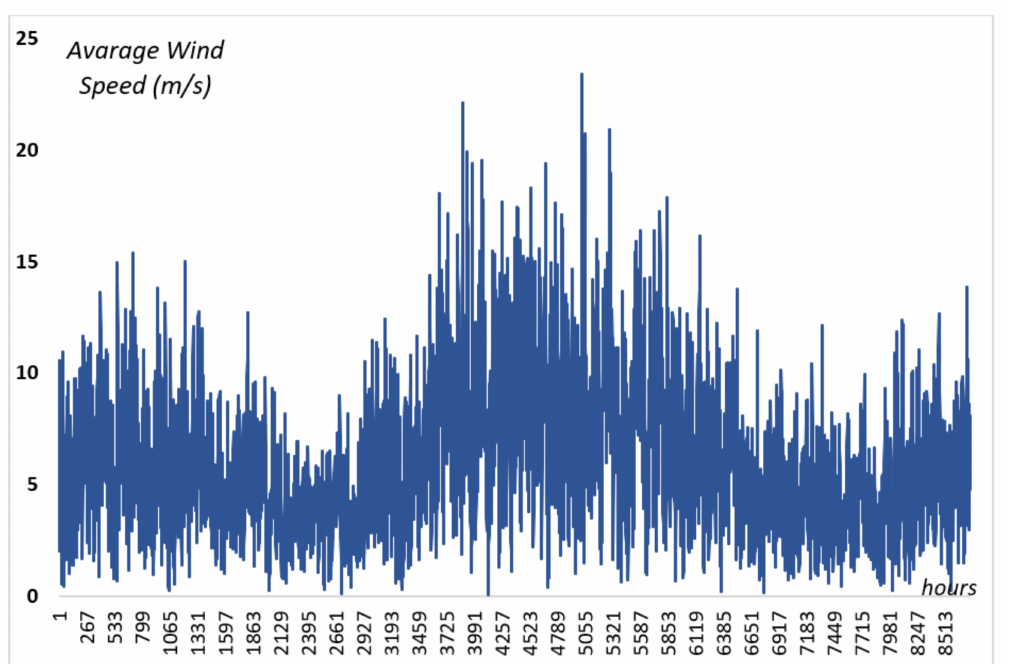
Figure 4. Hourly variation of the mean wind